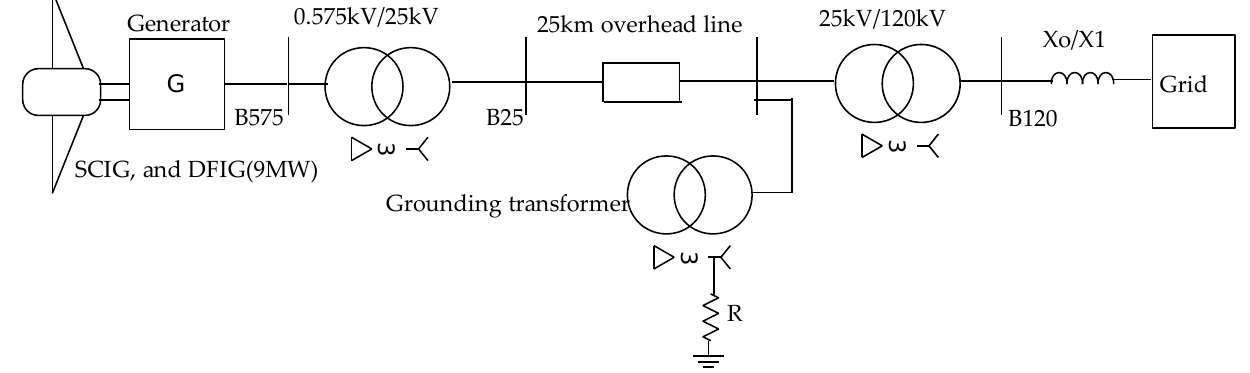
Figure 3. Single line diagram of the wind power plant integrated into a grid system.